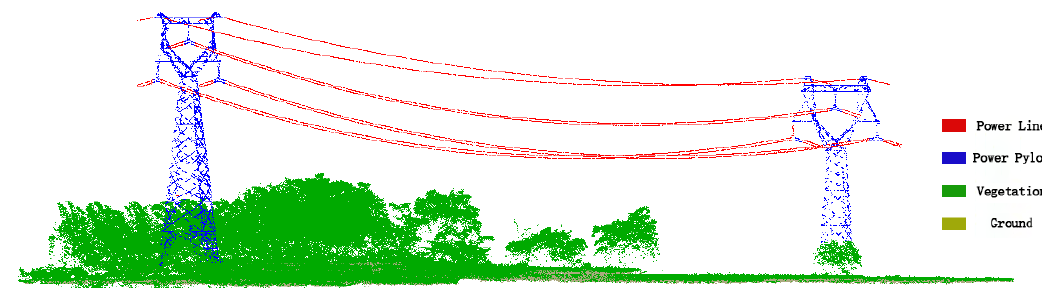
Figure 12. Point cloud in training region A. Table 3. Confusion matrix for classification of region B. Overall accuracy: 98.73%